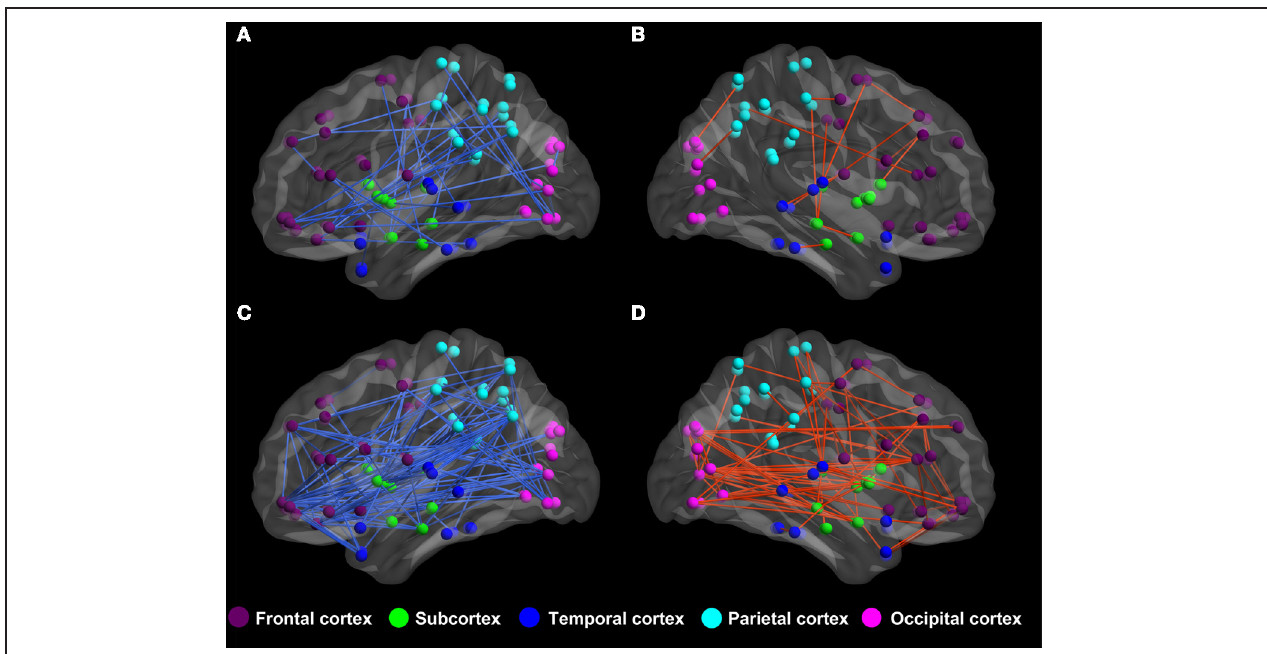
frequently in controls. (C,D) Altered functional connectivity in terms of spatial correlation ( p < 0 . 008, which is also used in feature selection). Red lines represent those links that are increased in terms of spatial correlation in ADHD patients, while blue lines are links that show decreased spatial correlation in ADHD